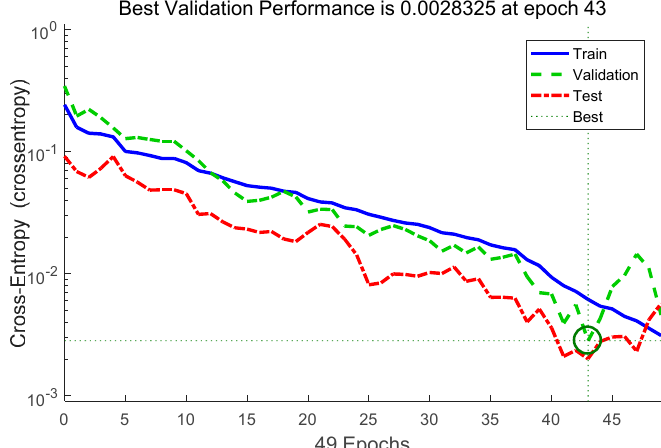
Figure 13. The performance graph of the trained neural network by epoch. Training set, validation set, and test set were evaluated, and the 43rd epoch neural network was used.